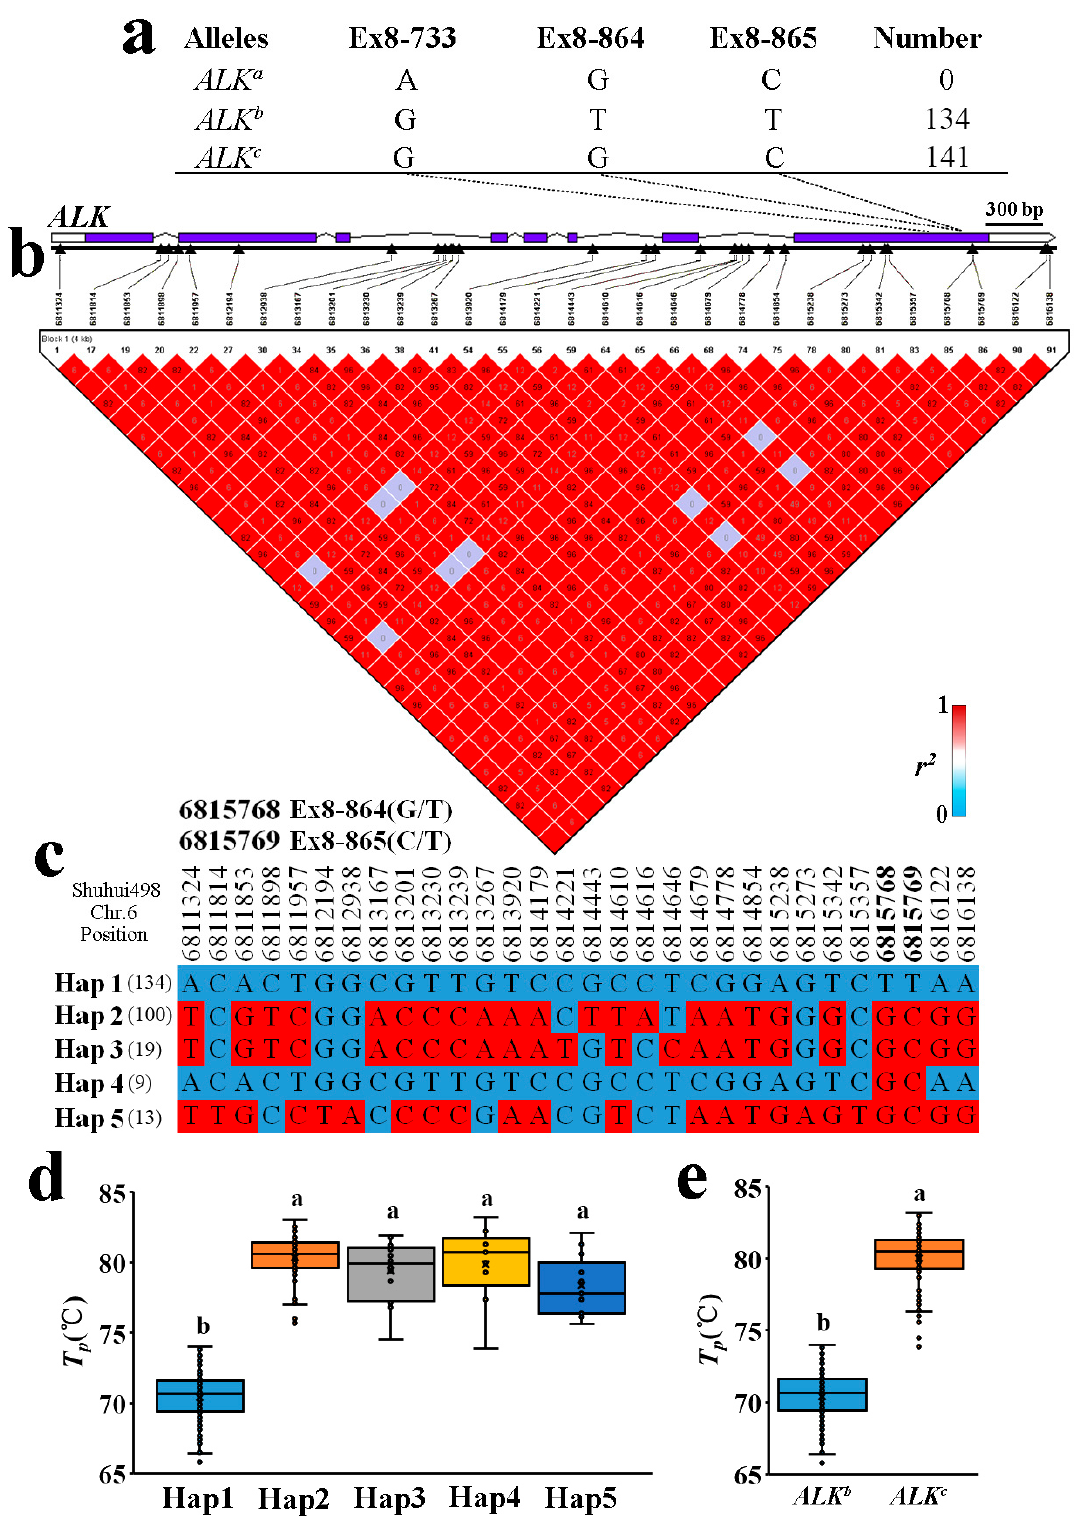
Figure 4. Analysis of different alleles and haplotypes of ALK . ( a ) Allele types and number of ALK s screened by KASP markers. ( b ) Linkage disequilibrium (LD) analysis. The r 2 value is shown on the matrix diagram. ( c ) Haplotype analysis. ( d ) Peak temperature of gelatinisation of different haplotypes. ( e ) Peak temperature of gelatinisation of different allele types. Different letters indicate significant differences ( p < 0.05).